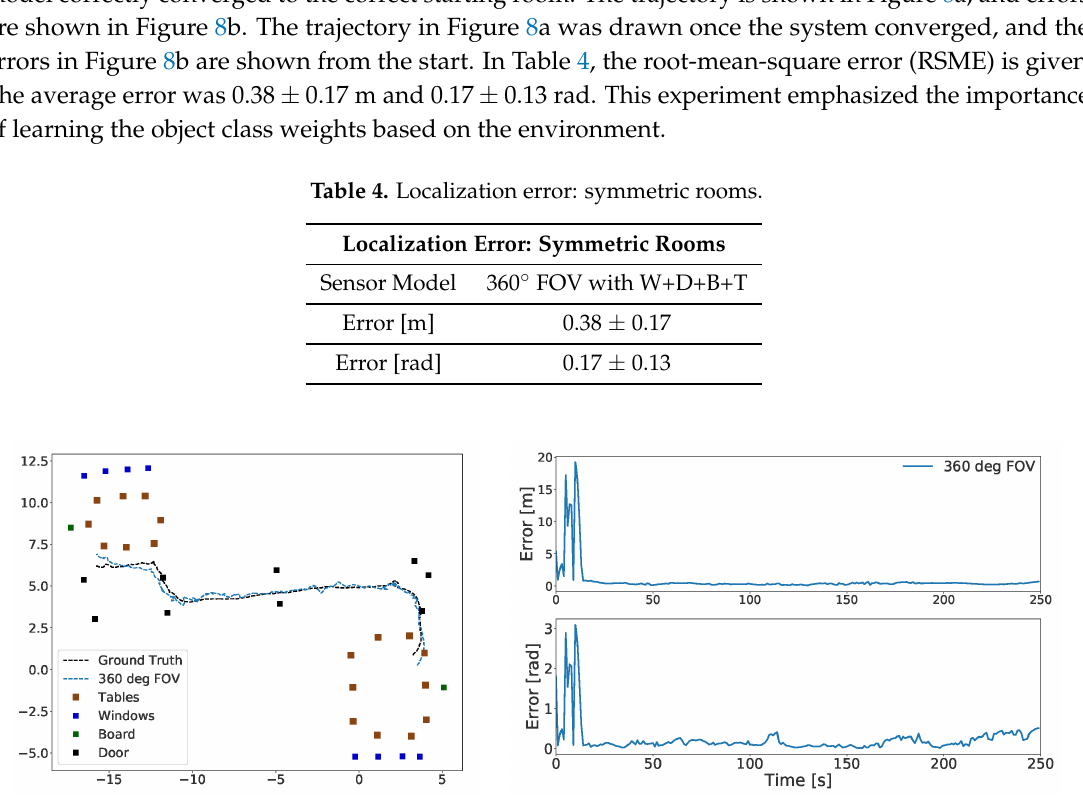
Figure 8. Trajectory and error for experiment in two rooms and corridor. Figure ( a ) shows the generated trajectory after convergence. ( b ) shows the error from initialization time. The ground truth is shown in